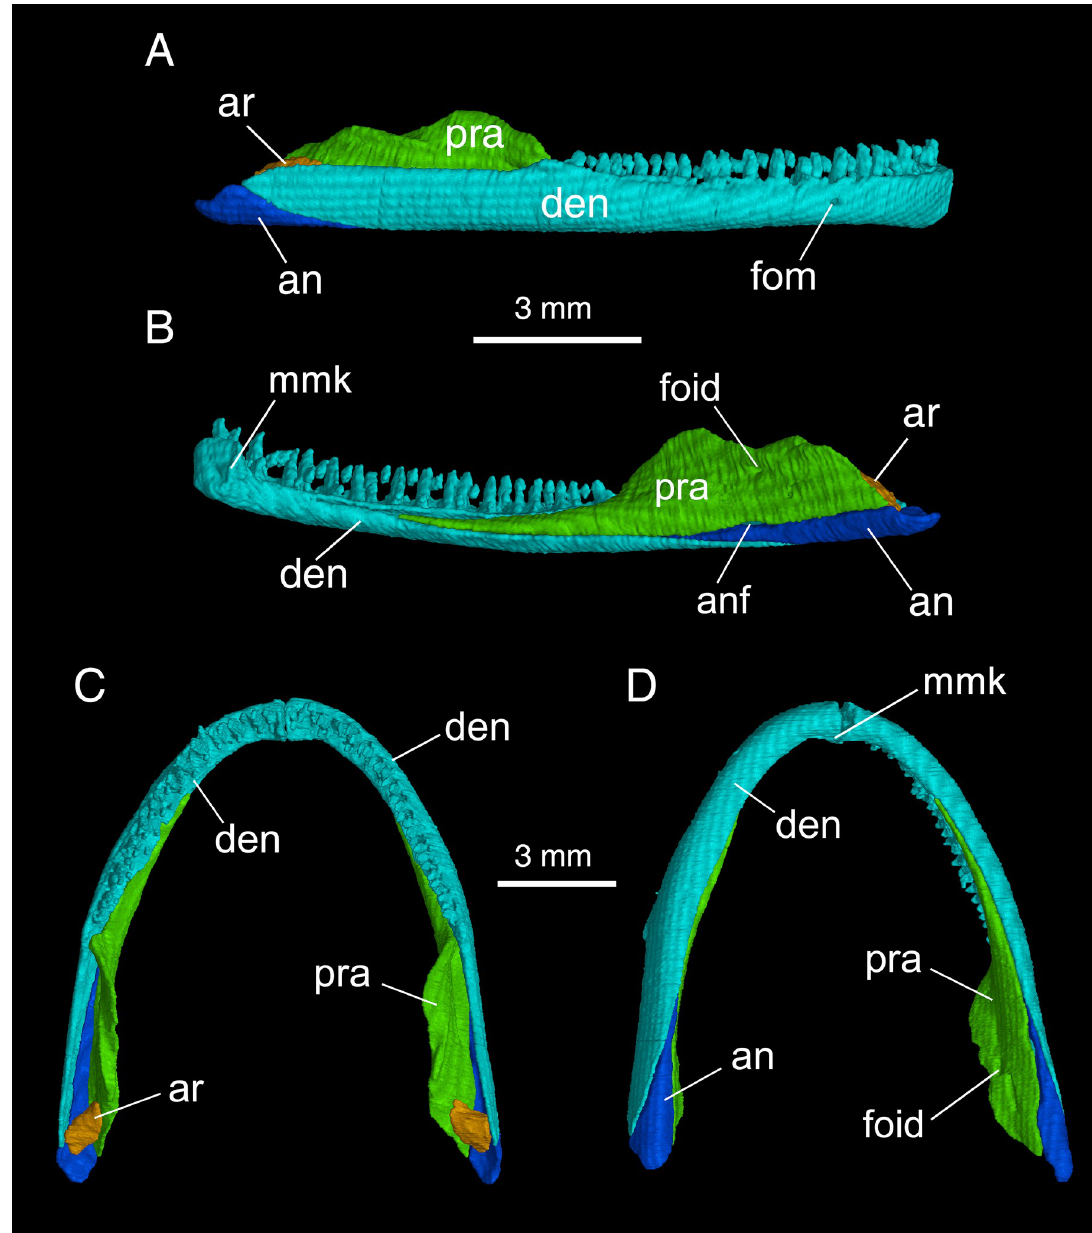
Fig 6. Micro-CT rendered reconstruction of the mandible of Batrachuperus yenyuanensis . A, right mandible in lateral view; B, right mandible in medial view; C, mandibular arch in dorsal view; D, mandibular arch in ventral view. FMNH 49371, paratype specimen, from Shuangertang, Yanyuan